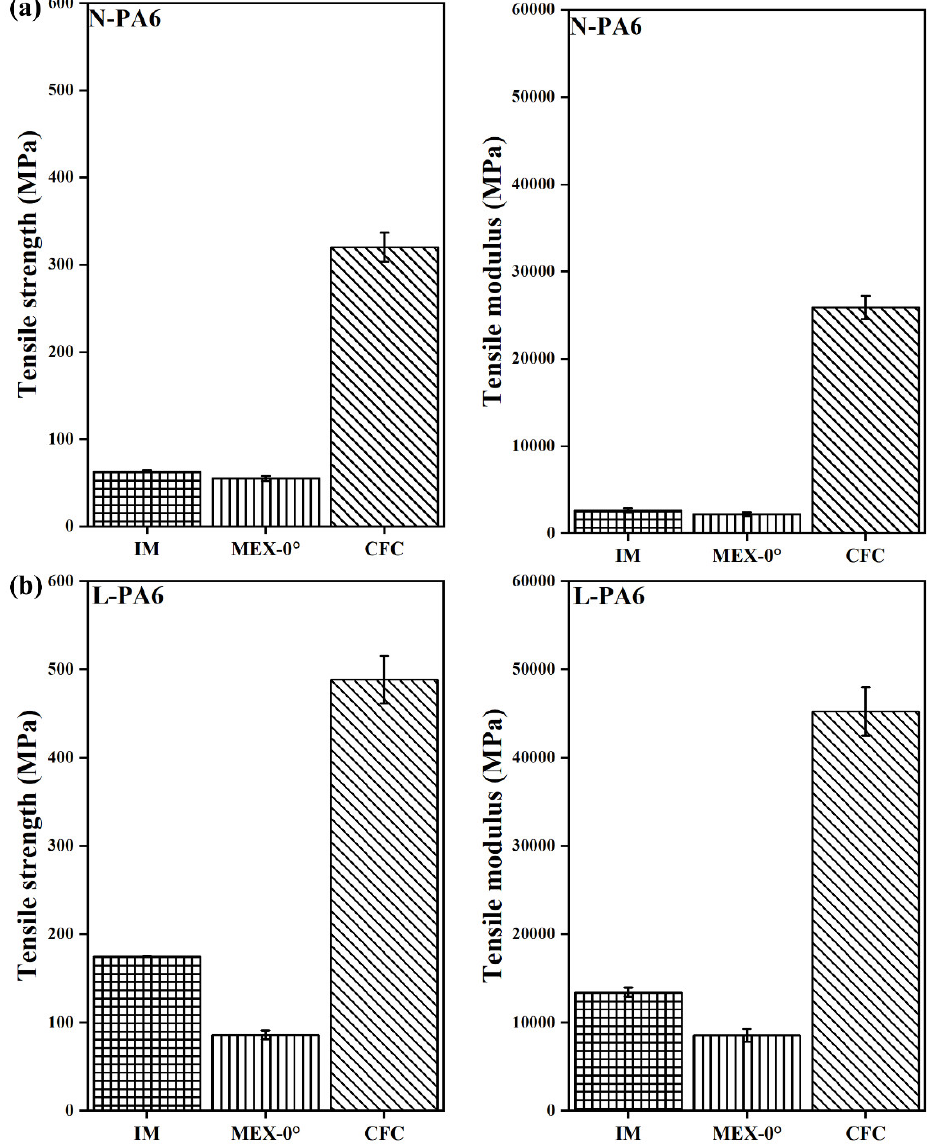
Figure 6. Tensile test data of PA6 with a corresponding error bar. Where, N-PA6 is neat PA6 and L PA6 is long carbon fibre reinforced PA6. The corresponding IM, MEX-0 ◦ , and CFC are injection moulded, 3D printed and composite filament co-extruded 3D printed tensile tested specimens,